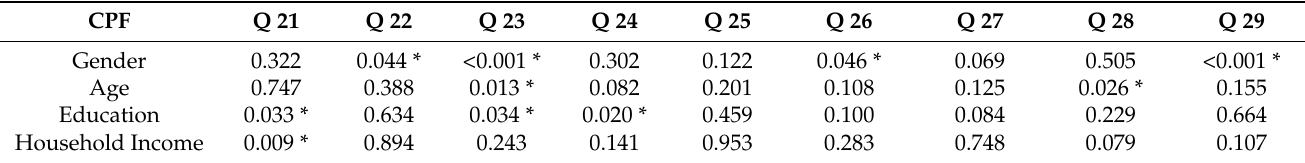
Table 3. Consumer’s personal factors and consumer